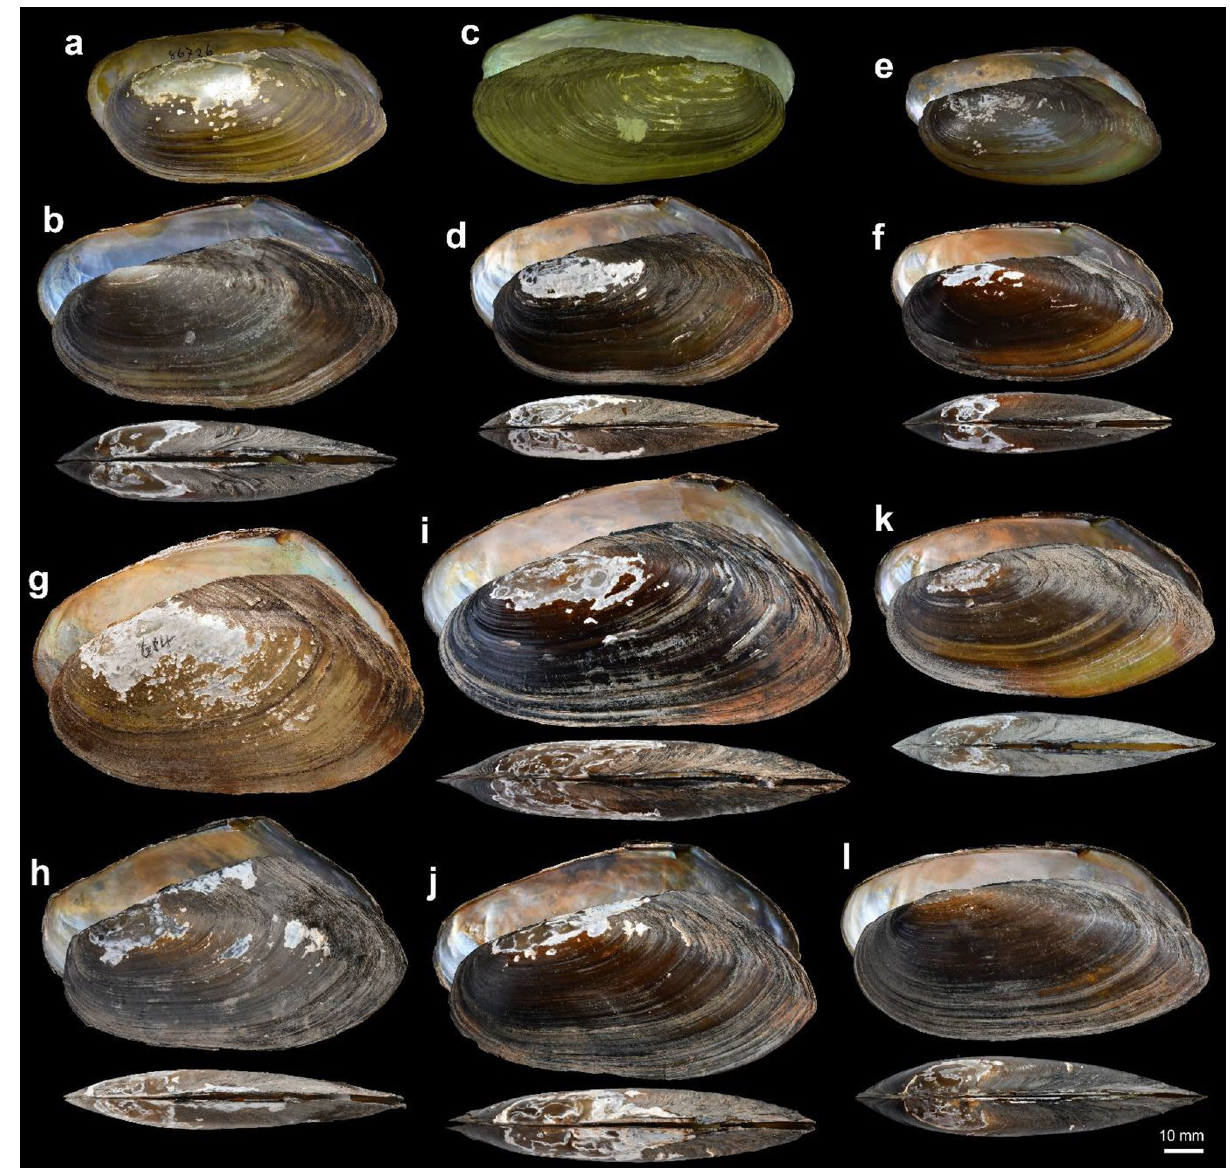
Figure 3. Shells of Pilsbryoconcha species. ( a,b ) P. exilis , ( a ) syntype USNM 86726, Java, ( b ) specimen MUMNH-UNI2792, Sa Kaeo, Thailand; ( c,d ) P. schomburgki , ( c ) holotype NHMUK 1859.5.23.8, Siam, ( d